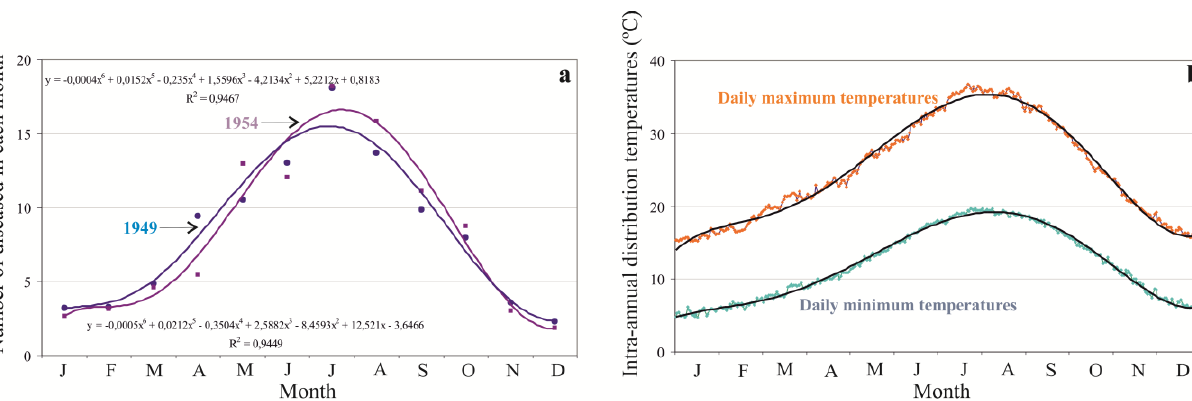
Figure 7. ( a ) Monthly percentage of the distribution of diseased people in 1949 and 1954 and their polynomial functions. ( b ) Inter-annual distribution of the minimum and maximum average temperatures between 1951 and 2001 in Southwestern Spain